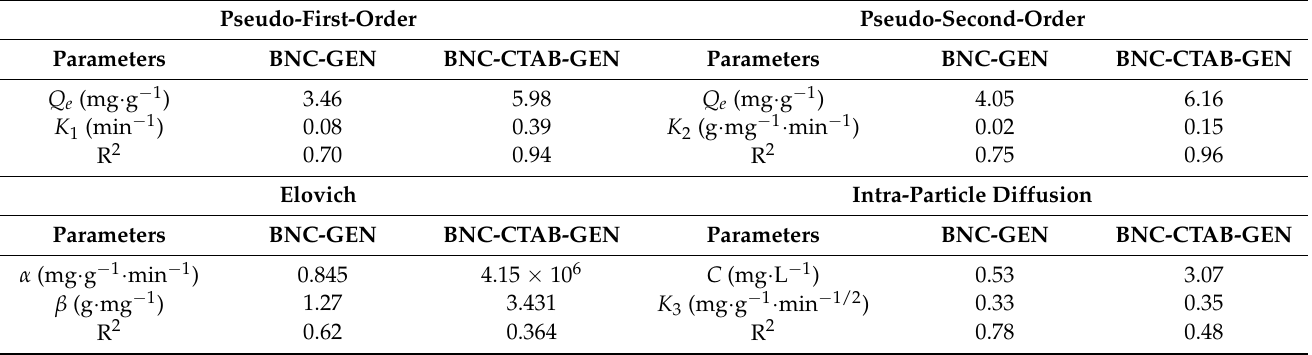
Figure 7. Adsorption kinetics results: ( a ) BNC-GEN; ( b ) BNC-CTAB-GEN; ( c ) BNC-GEN adjustment to Elovich model; ( d ) BNC-CTAB-GEN adjustment to Elovich model. Table 3. Adsorption kinetics